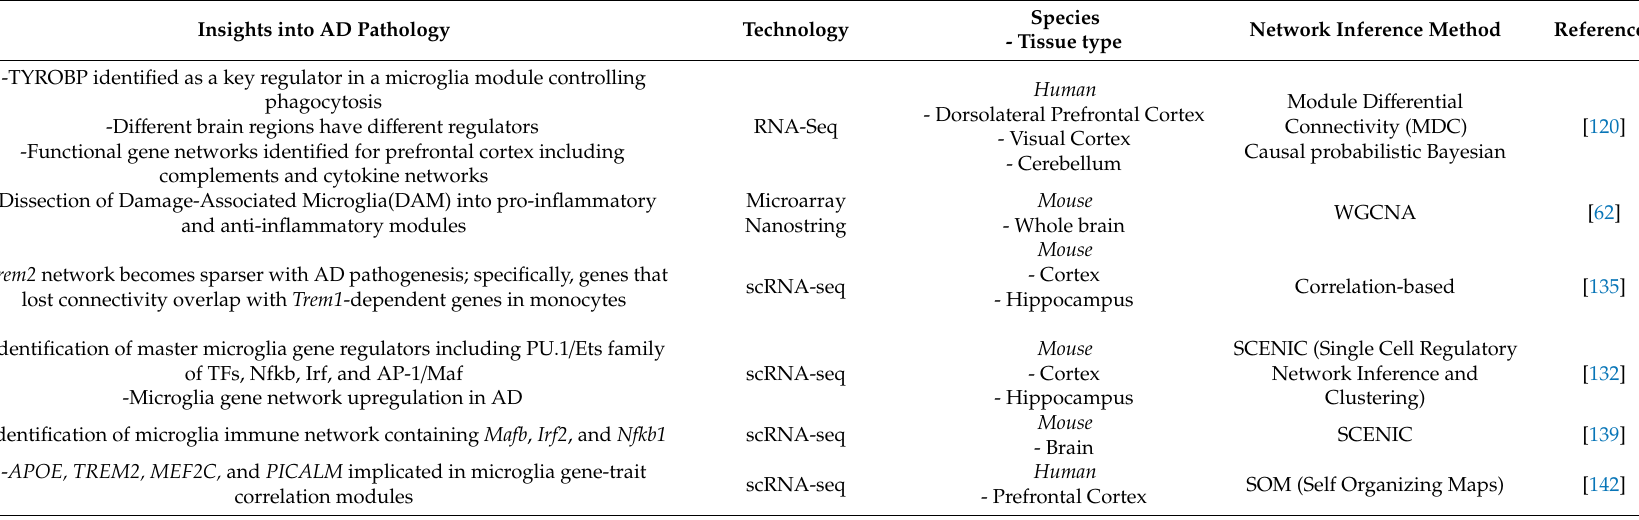
Table 2. Overview of the relevant biological insights into Alzheimer’s disease (AD) pathology obtained by transcriptional gene network analysis, which was performed using di ff erent transcriptomic technologies, species, tissue types and network inference